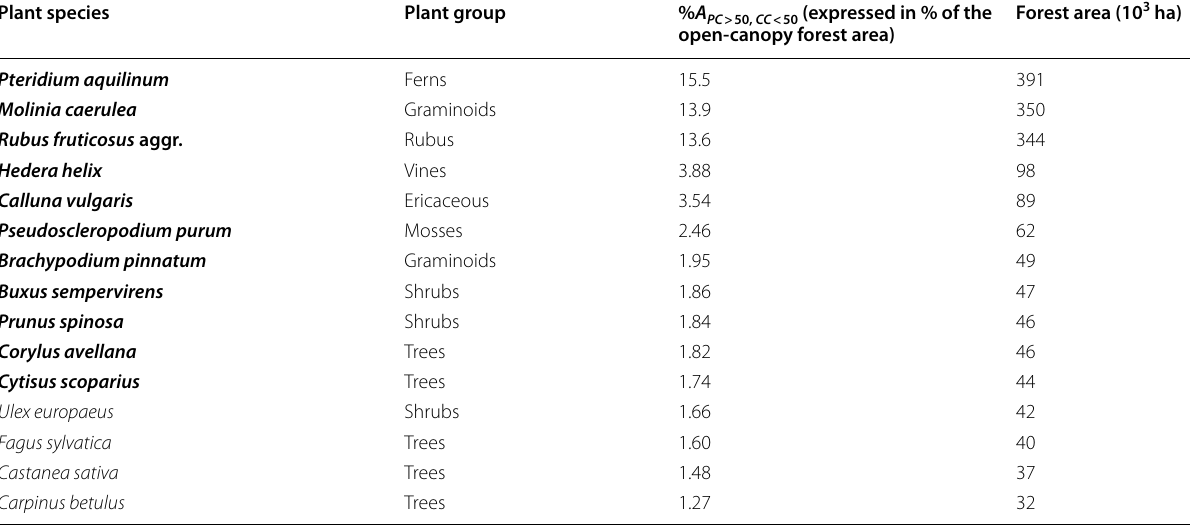
Table 3 Main species requiring vegetation control during the tree regeneration stage according to the indicator % A area with species cover > 50% in open‑canopy forests expressed in relative (% A estimated at the national scale (excluding the Mediterranean region) between 2006 and 2018. Species are ranked by decreasing % A values. For each species, the species group to which it belongs is indicated. Species in bold or plain type correspond PC > 50, CC < 50